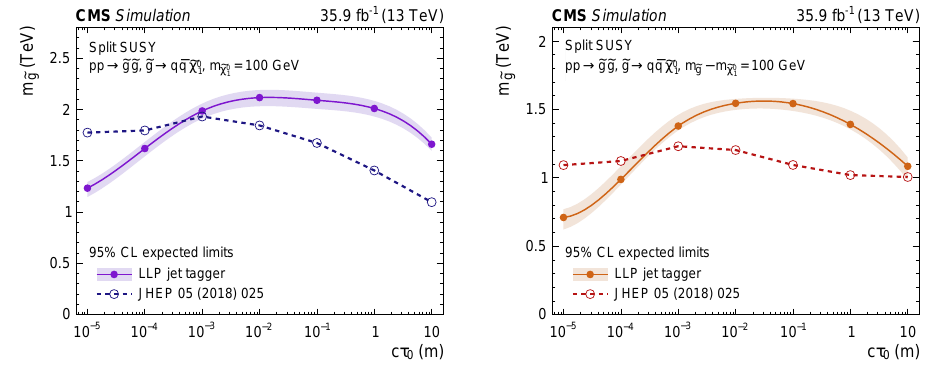
Figure 5. Expected 95% CL lower limit on the gluino mass as a function of c τ 0 for two examples of split SUSY. The figures are taken from Ref.